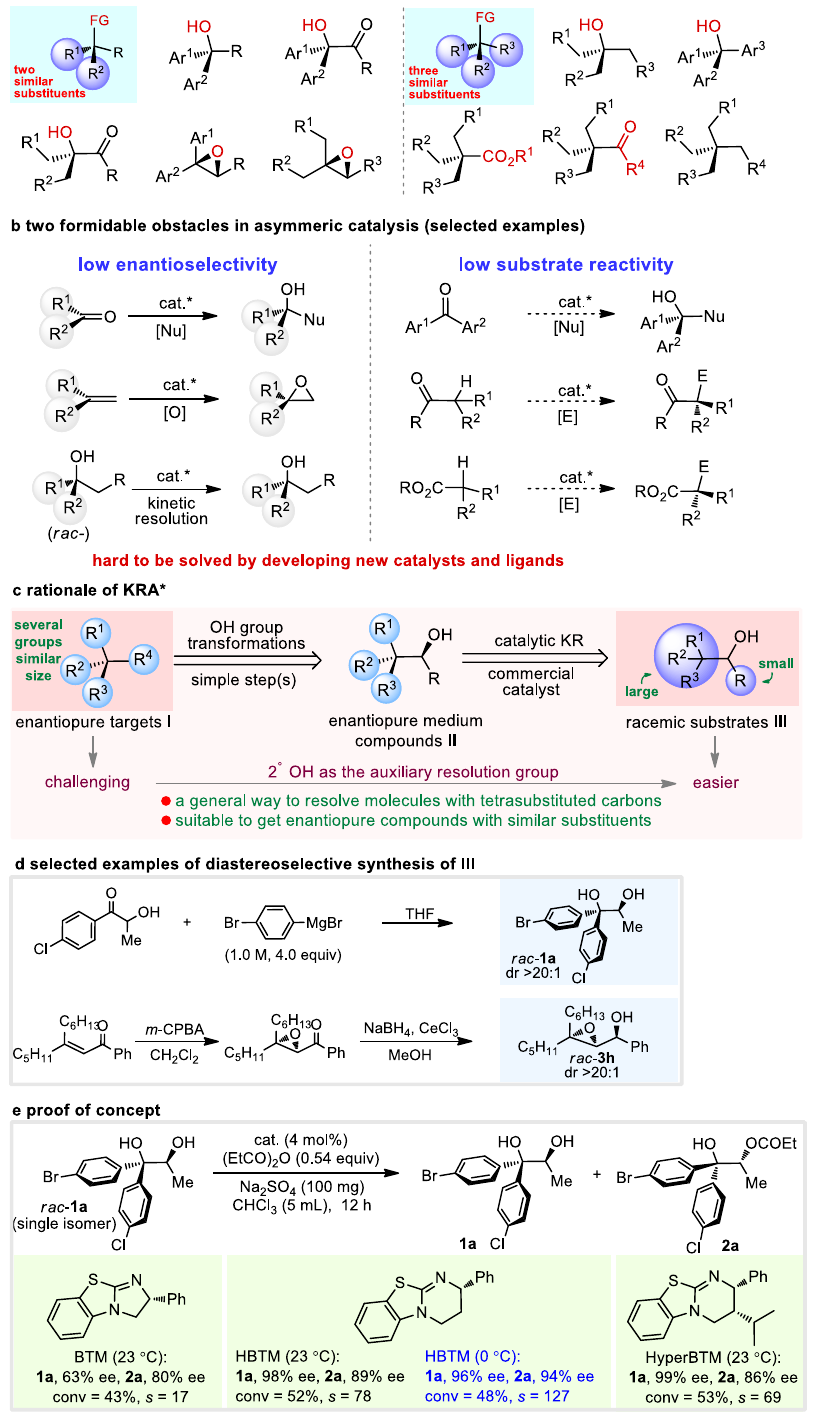
Fig. 1 Inspiration for the development of KRA*. a Challenging targets in asymmetric synthesis. b Two formidable obstacles in asymmeric catalysis. Cat.* catalyst, O oxidants, Nu nucleophiles, E electrophiles. c Rationale of hydroxy addition-kinetic resolution. d Selected examples of diastereoselective synthesis of III . e Proof of concept. Ee values were determined via HPLC analysis on a chiral stationary phase; selectivity factors ( s ) were calculated according to the following equation: s = ln [(1 − conv)(1 − ee 1a )]/ln[(1 − conv)(1 + ee 1a )], conv = (ee 1a )/(ee 1a + ee 2a tested to give moderate ee, and ethyl aryl ketone proved inert to system is usually compatible with activated ketones such as tri- fl uoromethyl ketones and α -ketocarbonyls 21,54,55 . Titanium- the reaction 20 . Also noteworthy is that, different from the catalyzed asymmetric Grignard addition to aryl ketones has also established secondary alcohol kinetic resolution mode using been developed, but in most cases, methyl aryl ketones were HBTM 50 , the π - π stacking in this process occurs between the Ar 1